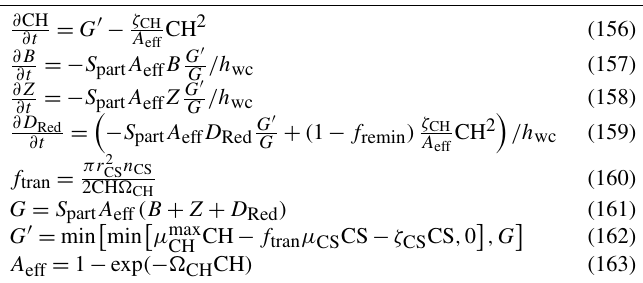
Table 27. Equations for the coral polyp model. The term CS /m B, N is the concentration of zooxanthellae cells. The equation for organic matter formation gives the stoichiometric constants; 12gCmolC − 1 ; 32gOmolO 2 − 1 . Other constants and parameters are defined in Table